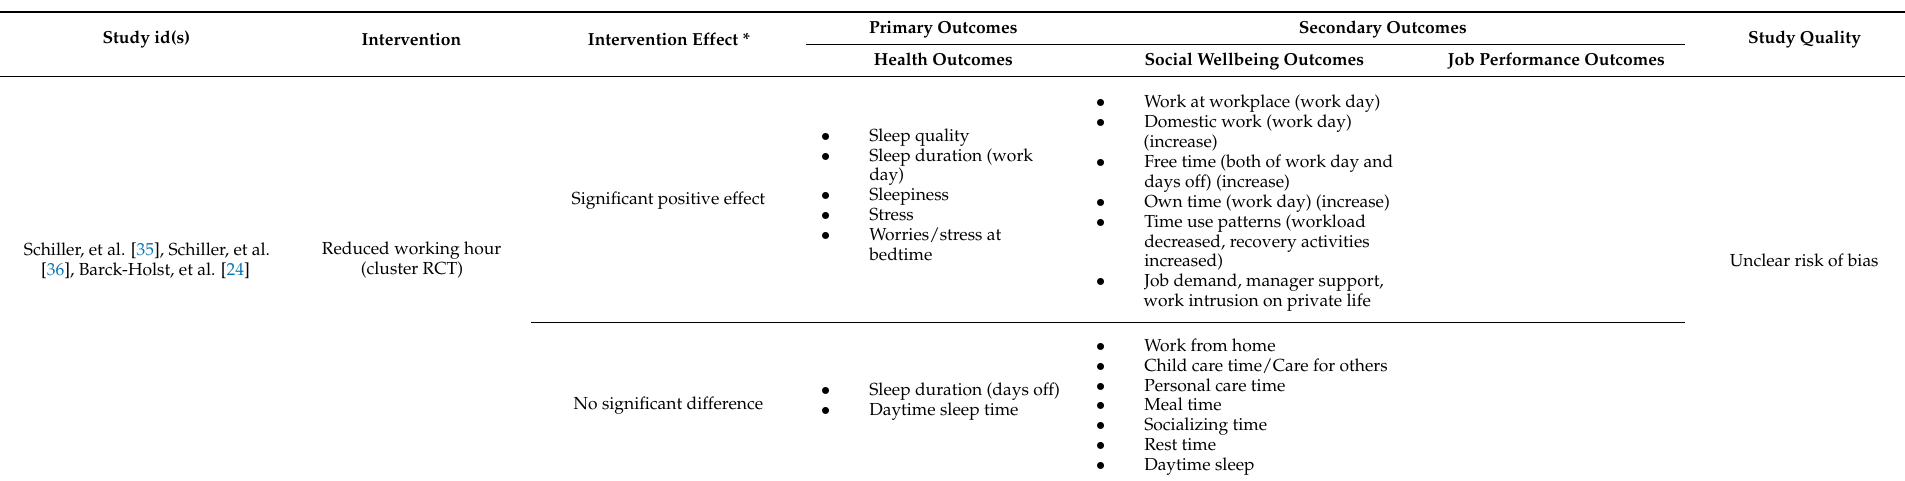
Table 2. Summary of intervention type, outcome measures † , overall results and quality assessment of included